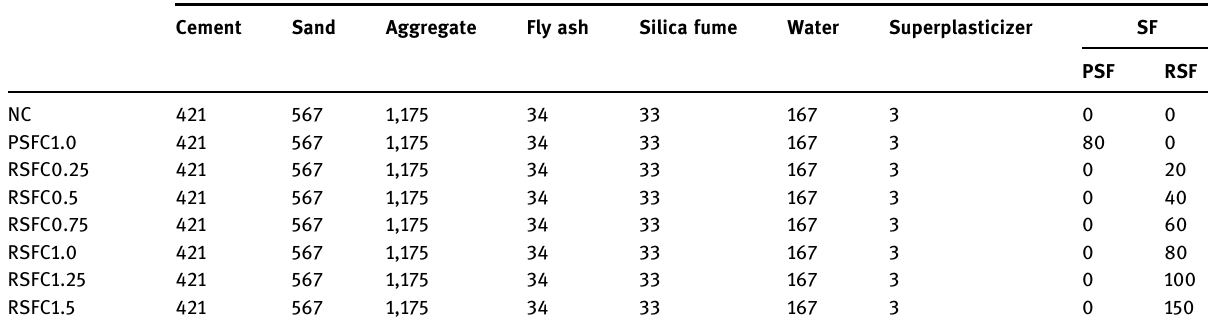
Table 1: Concrete mix proportion Test piece no